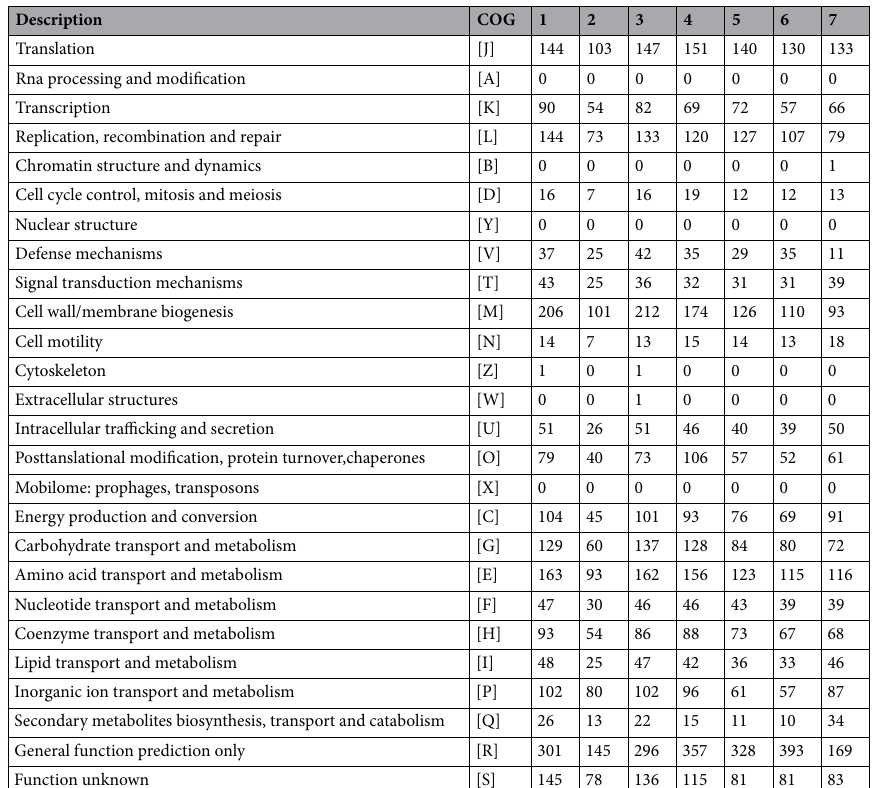
Table 4. Numbers of genes associated with the 25 functional categories in clusters of orthologous groups (COG). Akkermansia massiliensis strain Marseille-P6666 (1), Akkermansia muciniphila strain ATCC BAA- 835 T (2), Candidatus Akkermansia timonensis strain Akk0196 (3), Akkermansia glycaniphila strain Pyt T (4), “ Candidatus Akkermansia intestinavium” strain ChiGjej6B6-8097 T (5), “ Candidatus Akkermansia intestinigallinarum” strain 14975 T (6) and “ Candidatus Mariakkermansia forsetii” strain AKK7